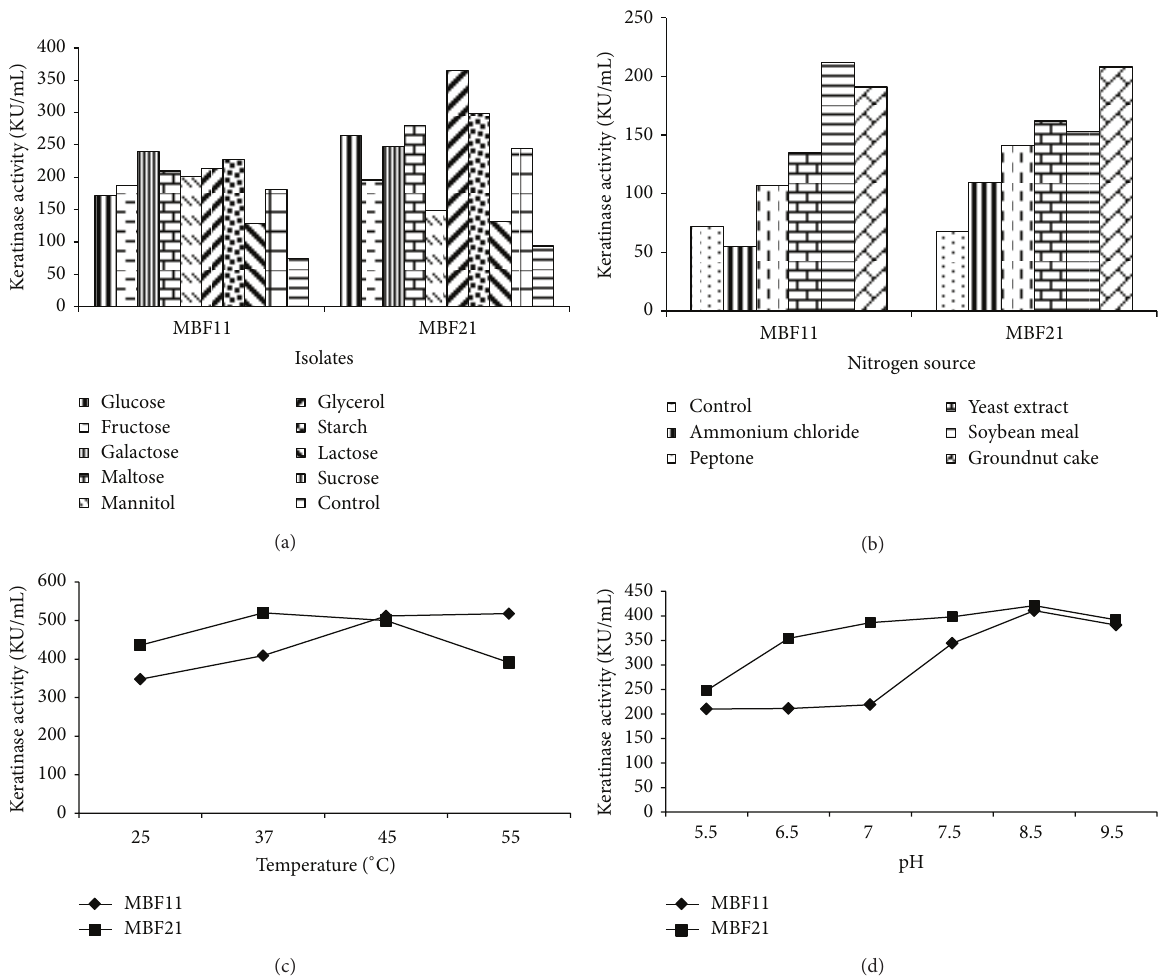
Figure 3: Optimization of nutritional and physical parameters for keratinase production by MBF11 and MBF21. Effect of (a) carbon sources, (b) nitrogen sources, (c) temperature, and (d) pH on keratinase production.